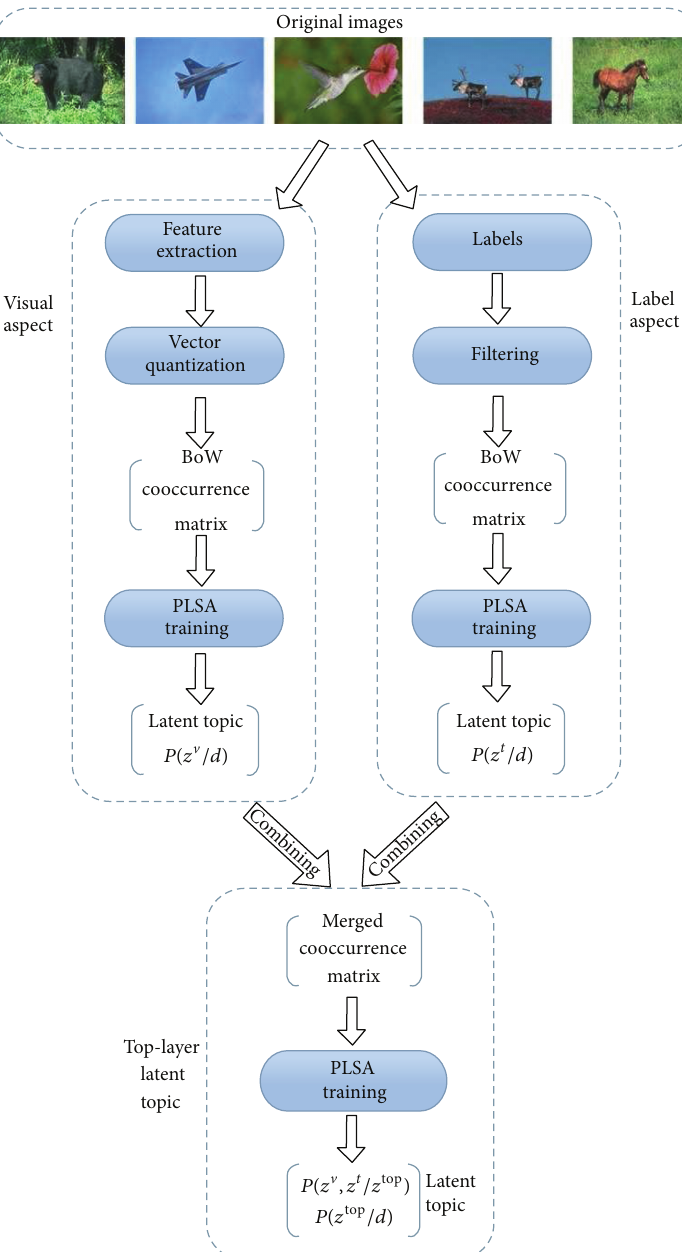
Figure 1: The flow diagram of the double-layer PLSA